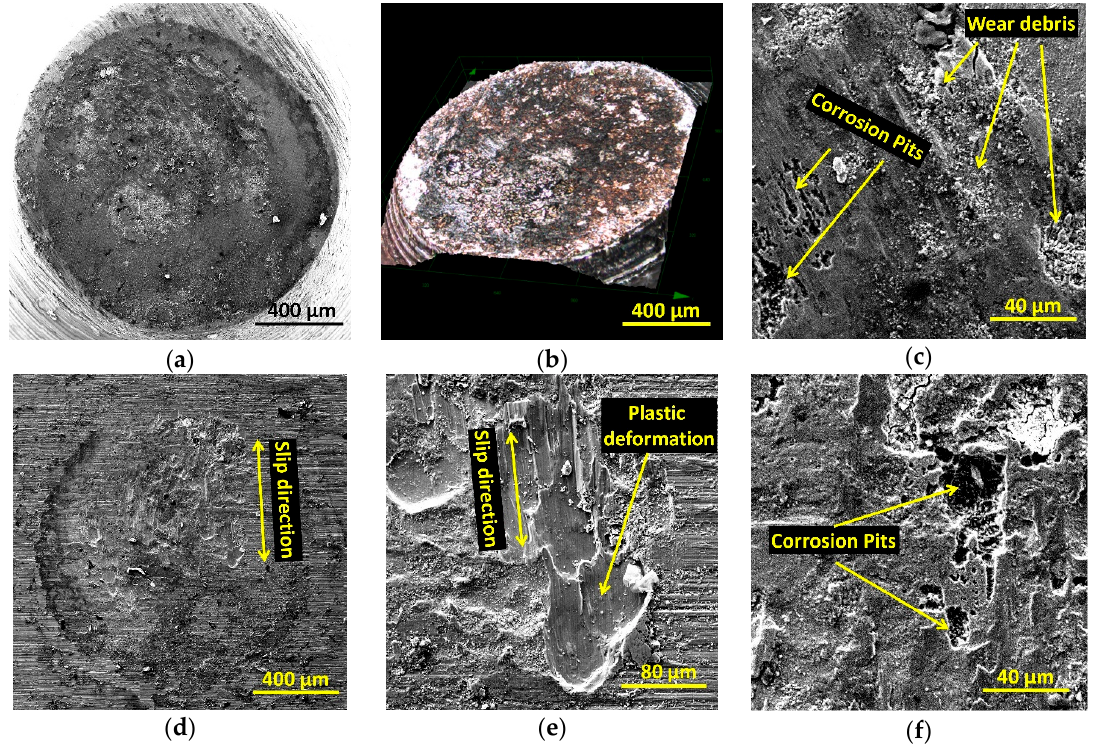
Figure 12. Surfaces of samples after fretting corrosion tests: ( a – c )—pin, ( d – f )—disc.